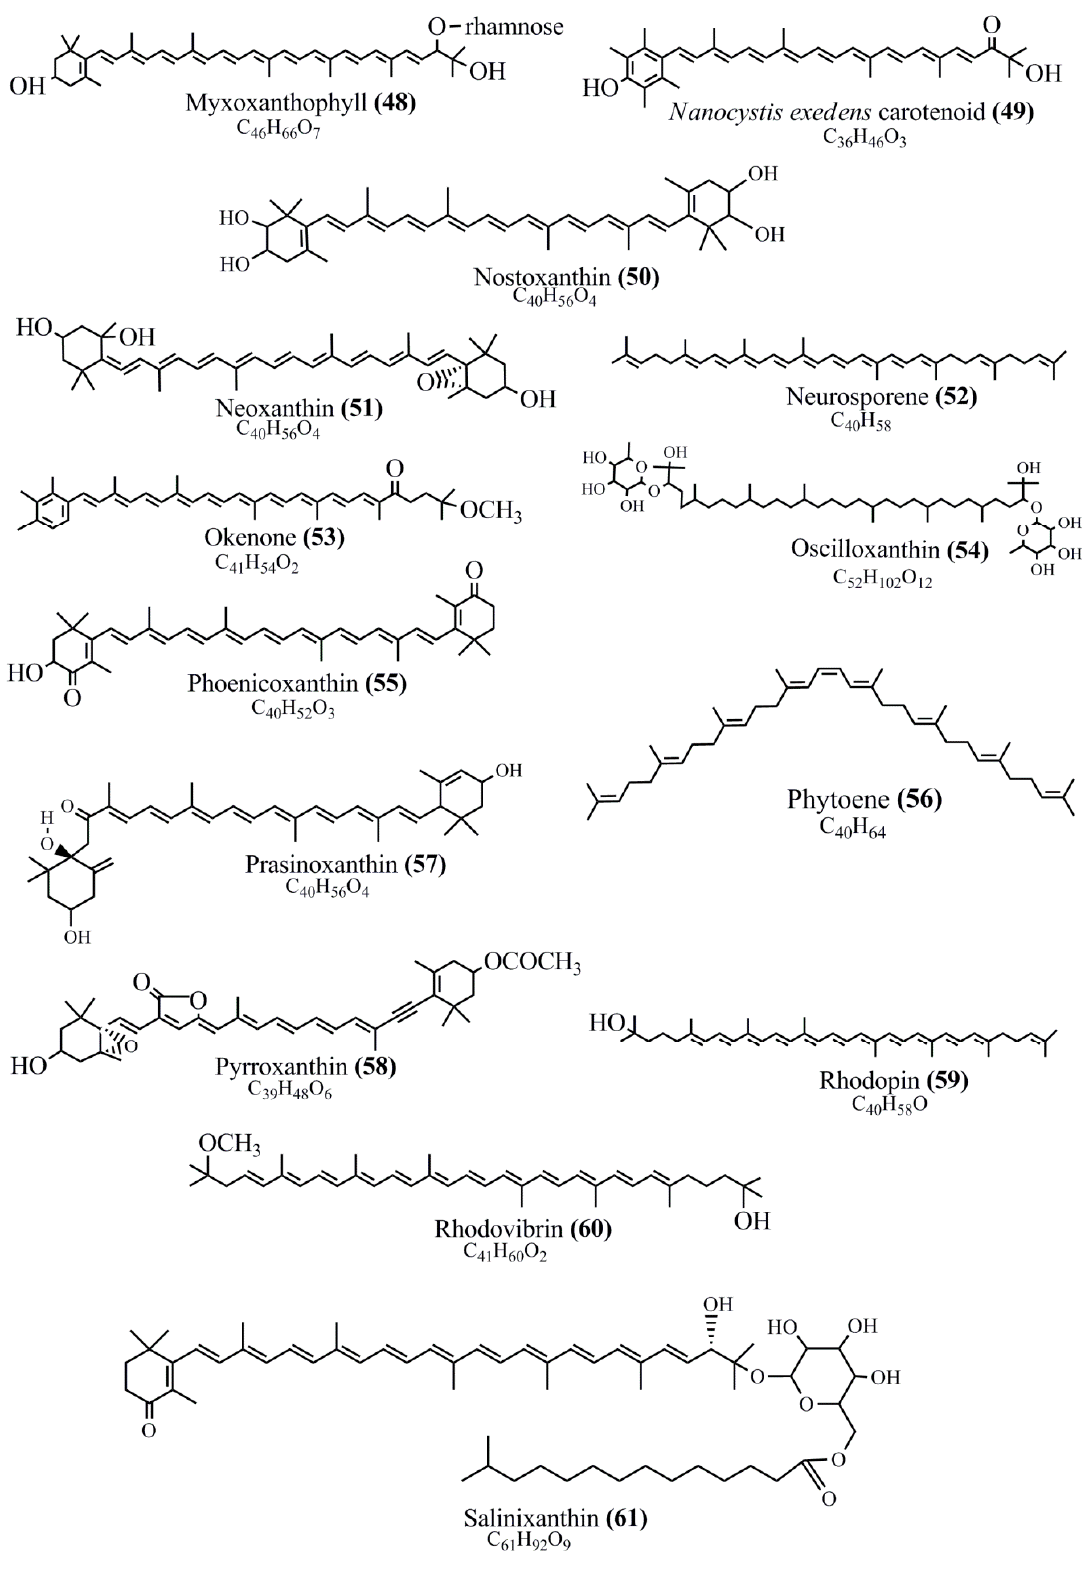
Figure 1. Figure 1. Continued.